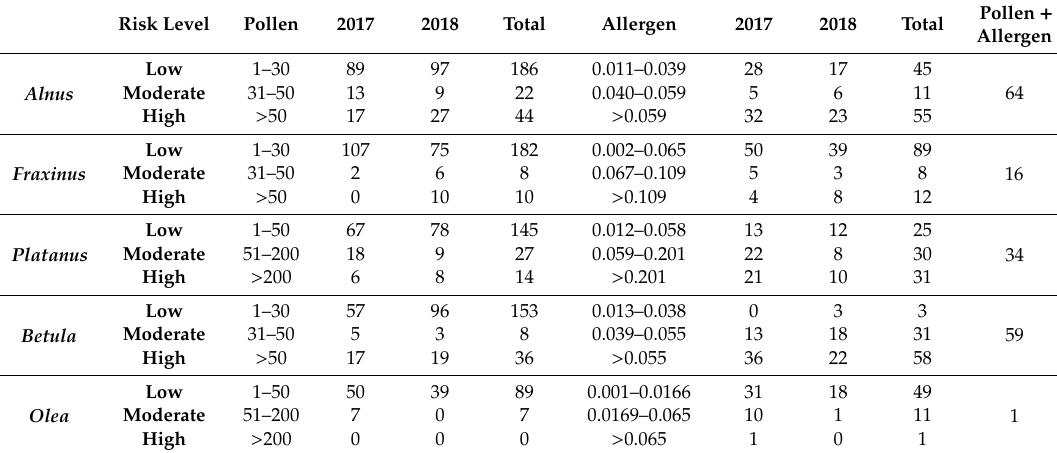
Table 4. Thresholds of allergenic risk for each taxon considering the pollen (Galán et al., 2007) and the allergens. Number of days with allergy risk periods for pollen or allergen. Total number of days during the period of study of high risk by means the combination of pollen and allergen data.